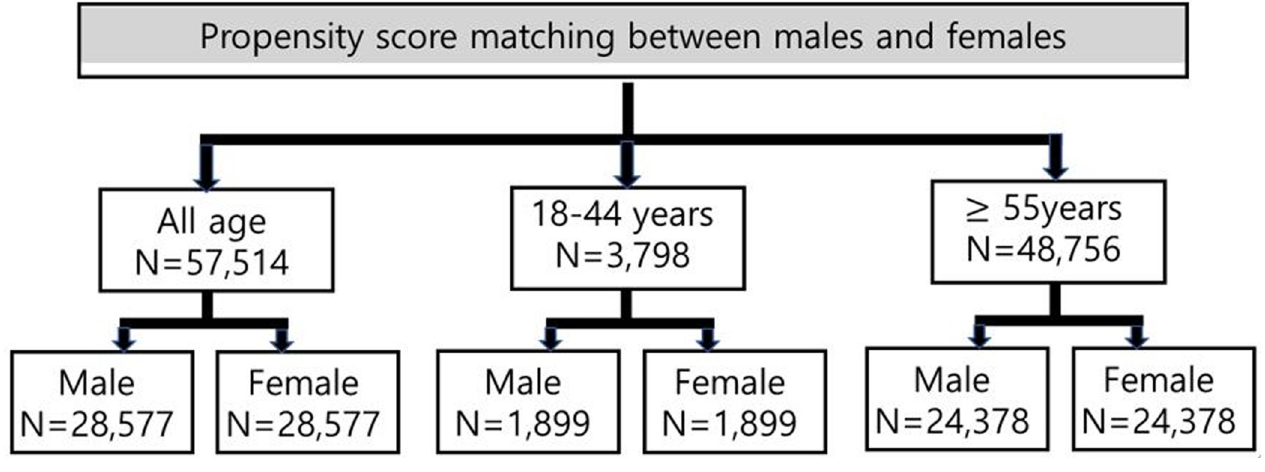
Fig 2. Inclusion after propensity score